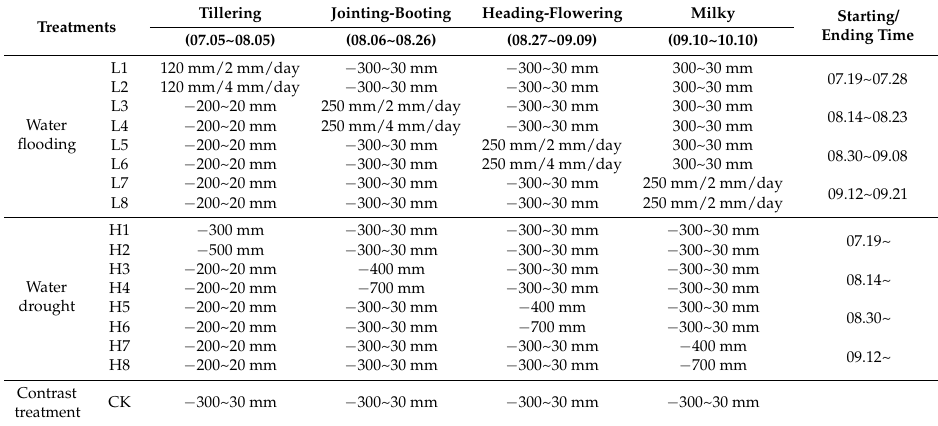
Table 1. Water level regulation scheme and water control stages division in 2011 and 2012. Tillering Jointing-Booting Treatments